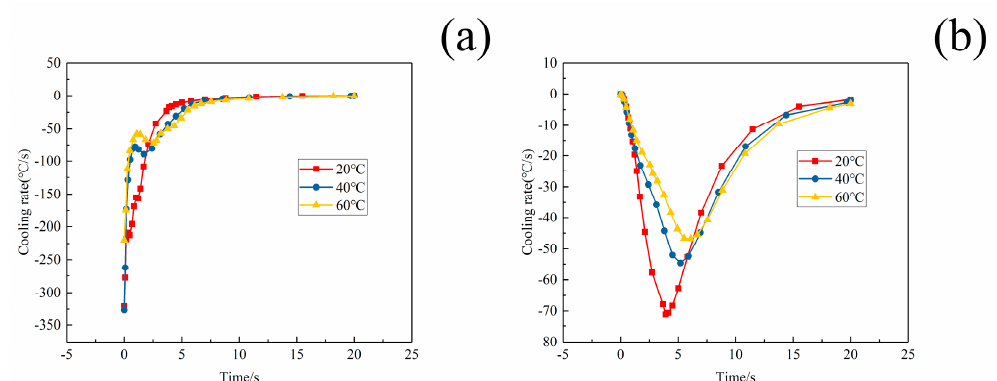
Figure 11. The cooling rates of the points of W / 2024Al composite blocks quenched by water of di ff erent temperatures; ( a ) The point of maximum compressive stress; ( b ) The point of maximum tensile stress.